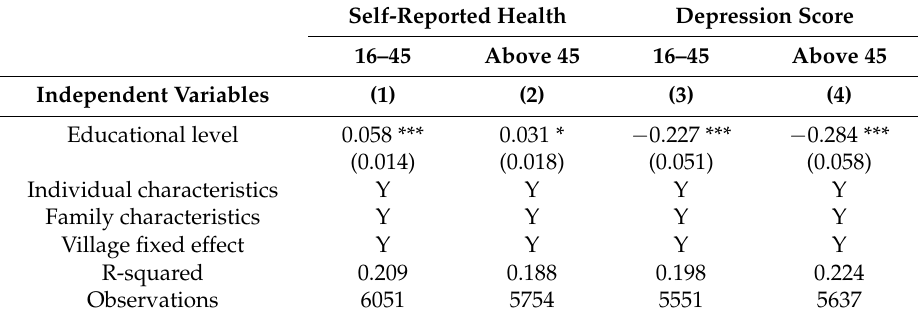
Table 5. The impact of education on health by age cohorts (OLS).